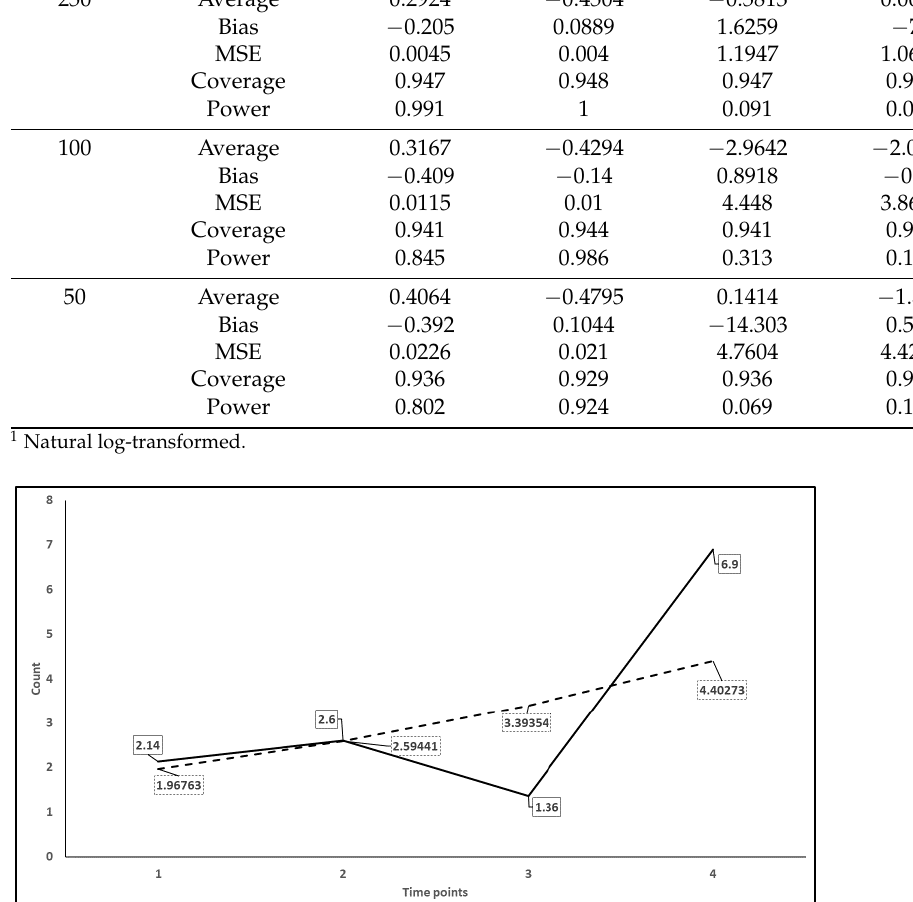
Figure 2. Histograms for the three area under the curve (AUC) measures for the N = 50 simulation. Panel A : AUC—i; Panel B : AUC—g; Panel C : LN AUC—g.